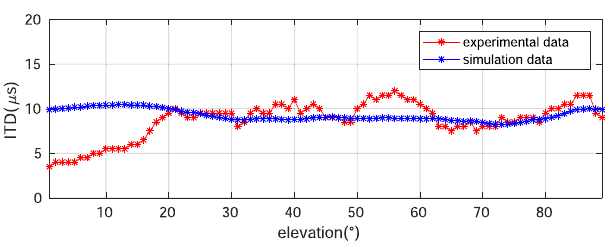
Figure 9. Comparison of the time difference between the signals received at the left and right receivers obtained from the experimental (red) and simulation (blue) data. Uncertainty of the experimental values is around 5 l